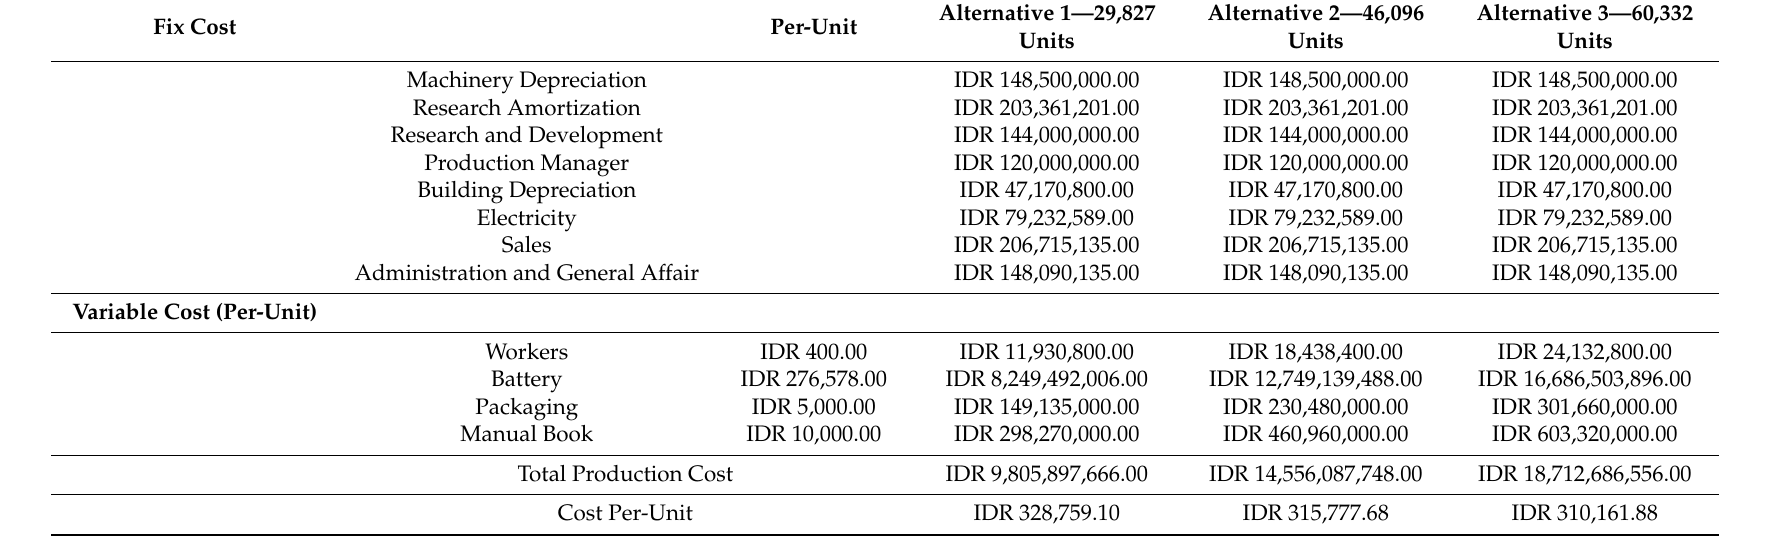
Table 6. Product Cost